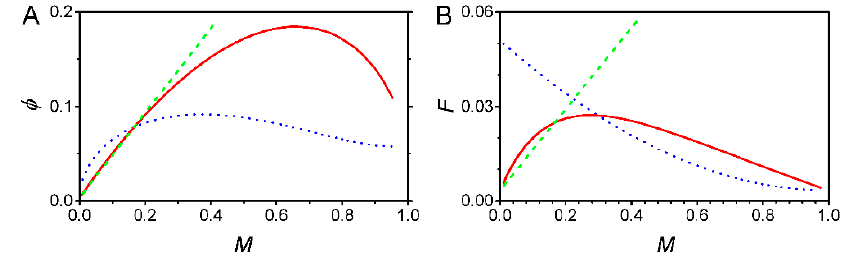
Figure 2. The two-state model intrinsically supports frequency modulation. ( A ) The stand deviation φ and ( B ) the Fano factor F as functions of transcriptional level M . Dashed-blue line, frequency modulation; Dashed-green line, magnitude modulation; Red line, duration modulation. The default parameter values are α = 0.5 min − 1 , β = 1 min − 1 , ε = 15 min − 1 , and δ = 1 / 20 min − 1 . All the data were normalized by setting the maximal transcriptional level ε / δ = 1. Changing the values in the biologically reasonable range did not affect the conclusions.